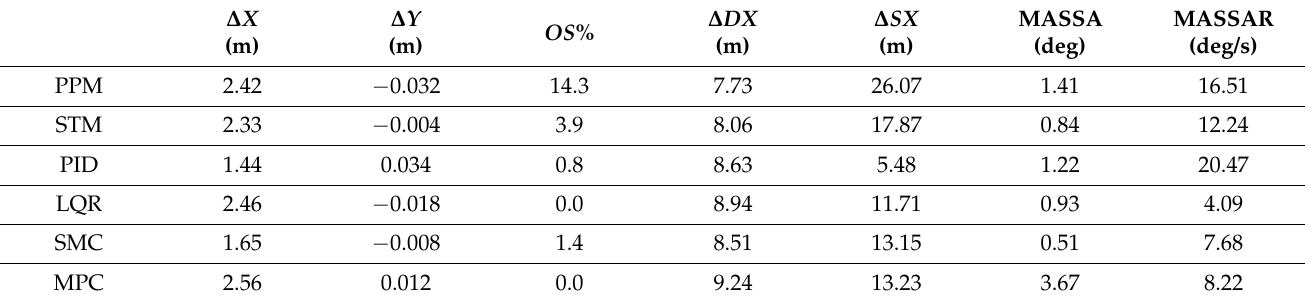
Table 7. Summary of simulation results of each controller for 4WS vehicle in the third set of simulations.